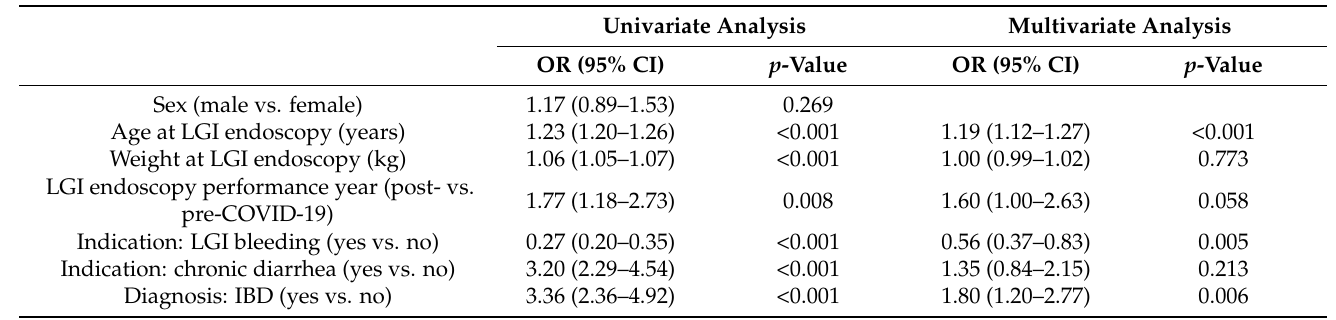
Table 6. Logistic regression analyses of factors associated with the conductance of a colonoscopy over a